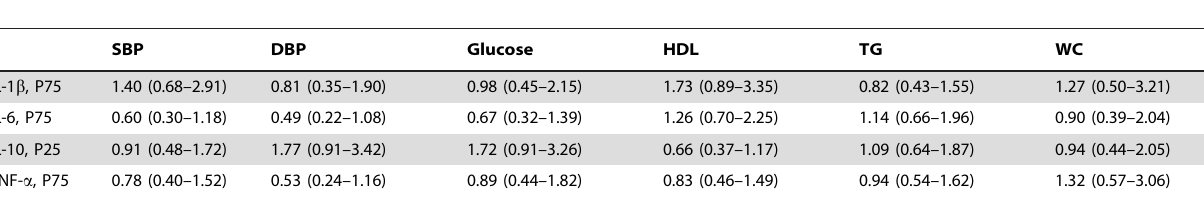
Table 6. Association between cytokines values (in quartiles) and markers of the metabolic syndrome in 311 postmenopausal